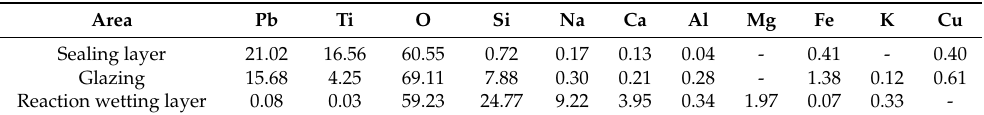
Figure 7. The XRD analysis results of the sealing layer. Table 4. EDS analysis results for each region